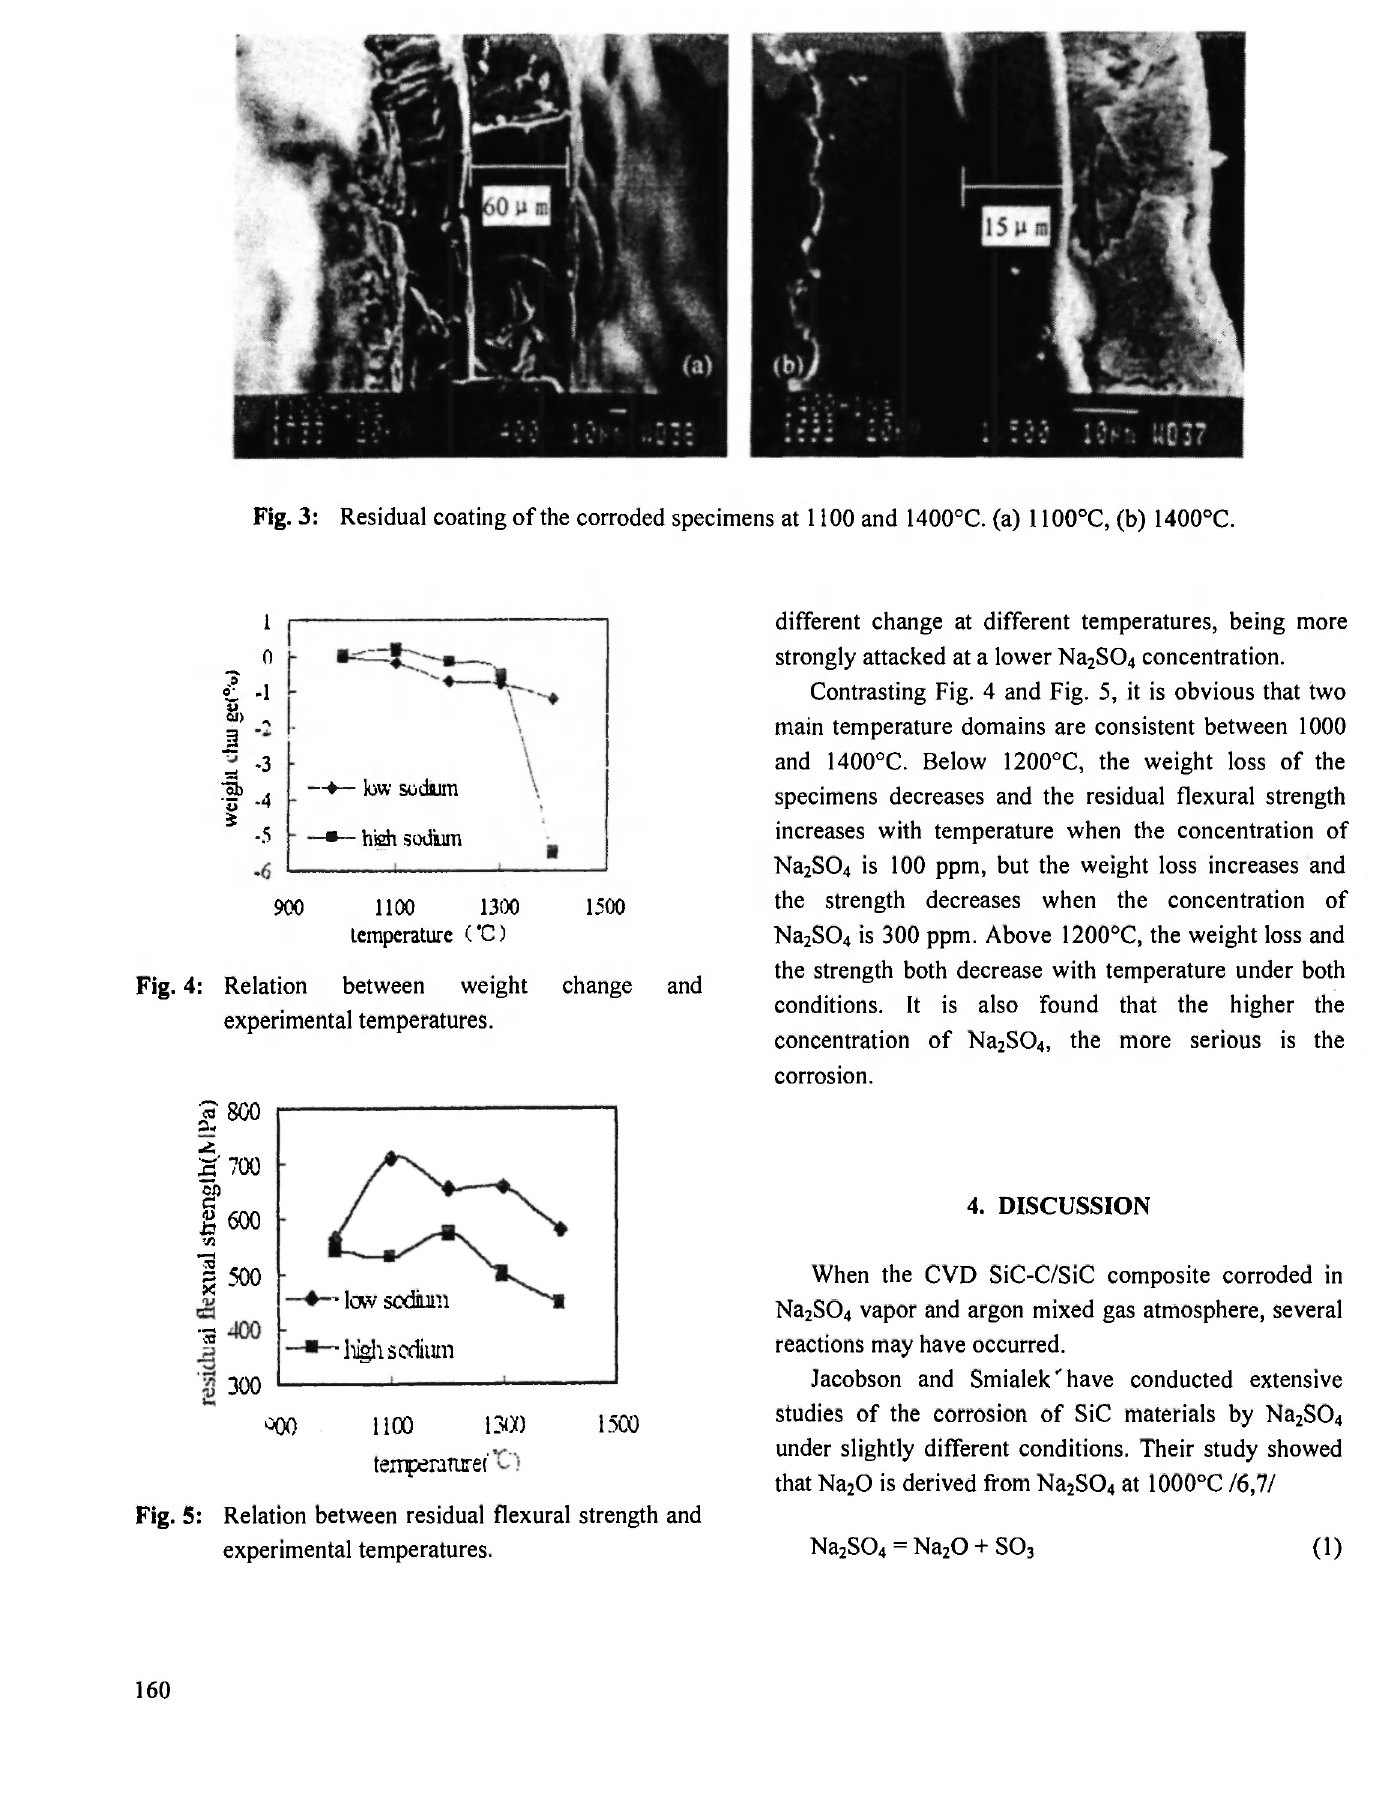
Fig. 5: Relation between residual flexural strength and experimental